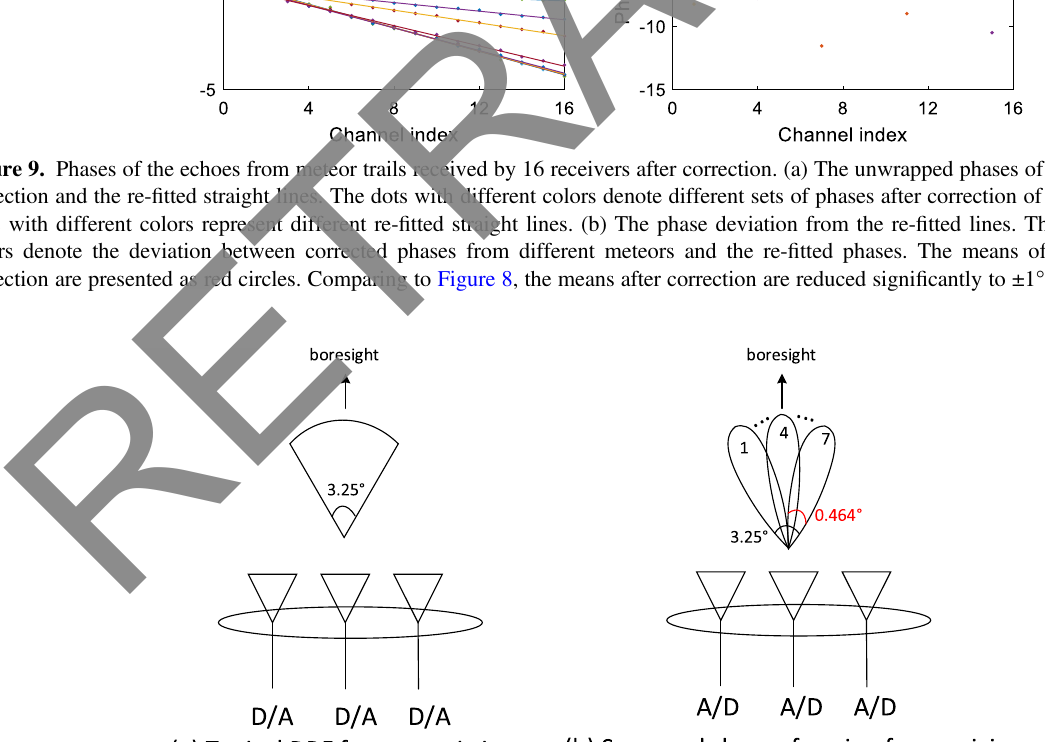
Figure 10. Schematic diagram of beam forming for transmitting and receiving in the AgileDARN radar. (a) Typical DBF for transmitting with a beamwidth of 3.25 (cid:3) . (b) Seven sub-beam forming for receiving to separate 3.25 (cid:3) into seven sub-beams of 0.464 (cid:3)